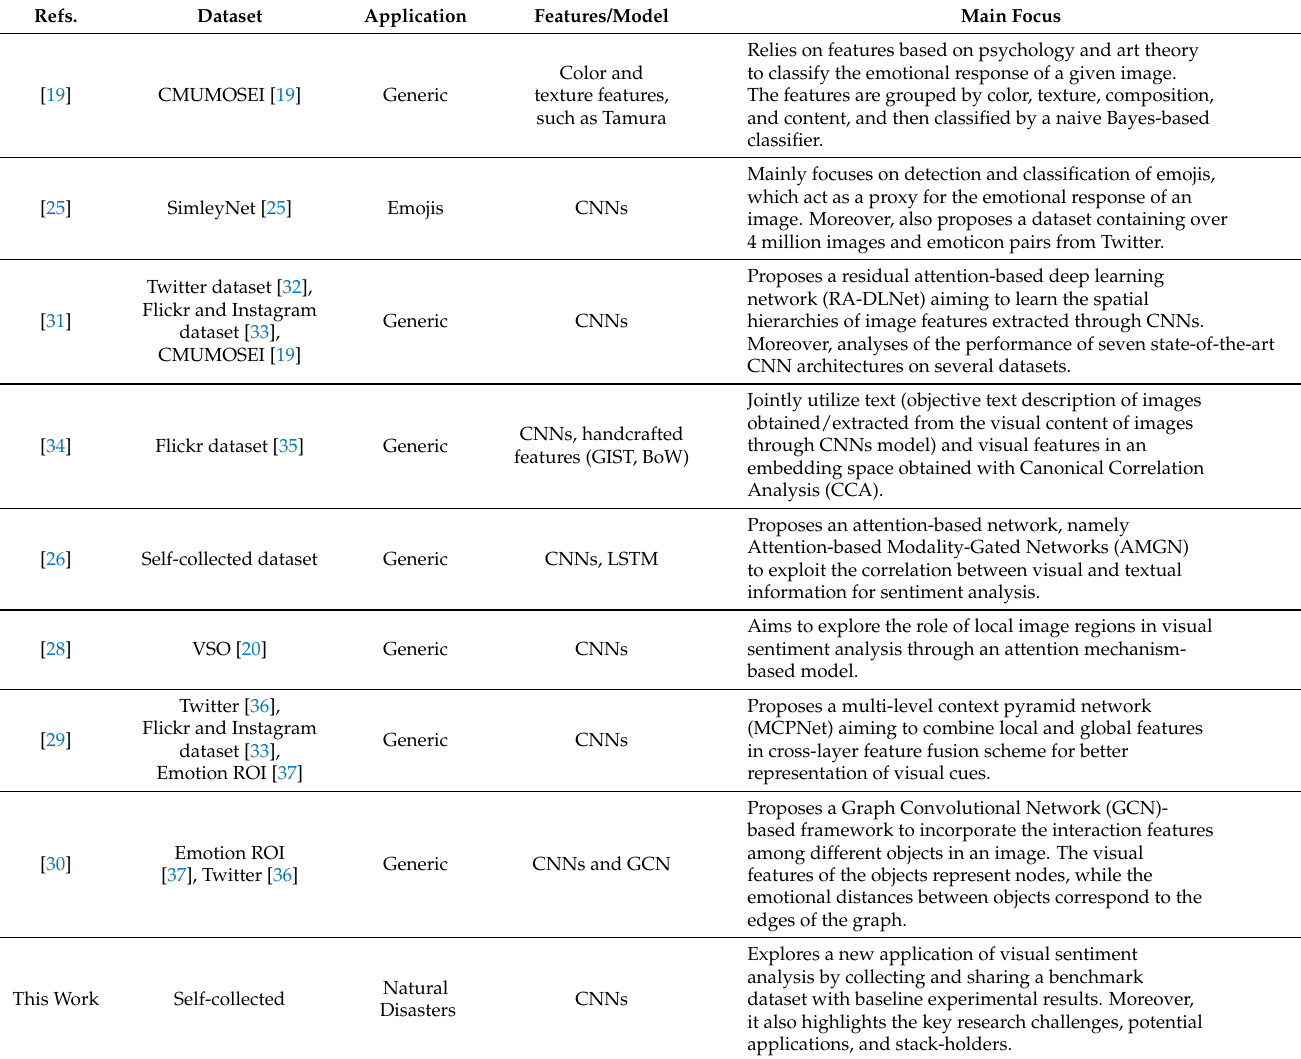
Table 1. A summary and comparative analysis of existing works on the